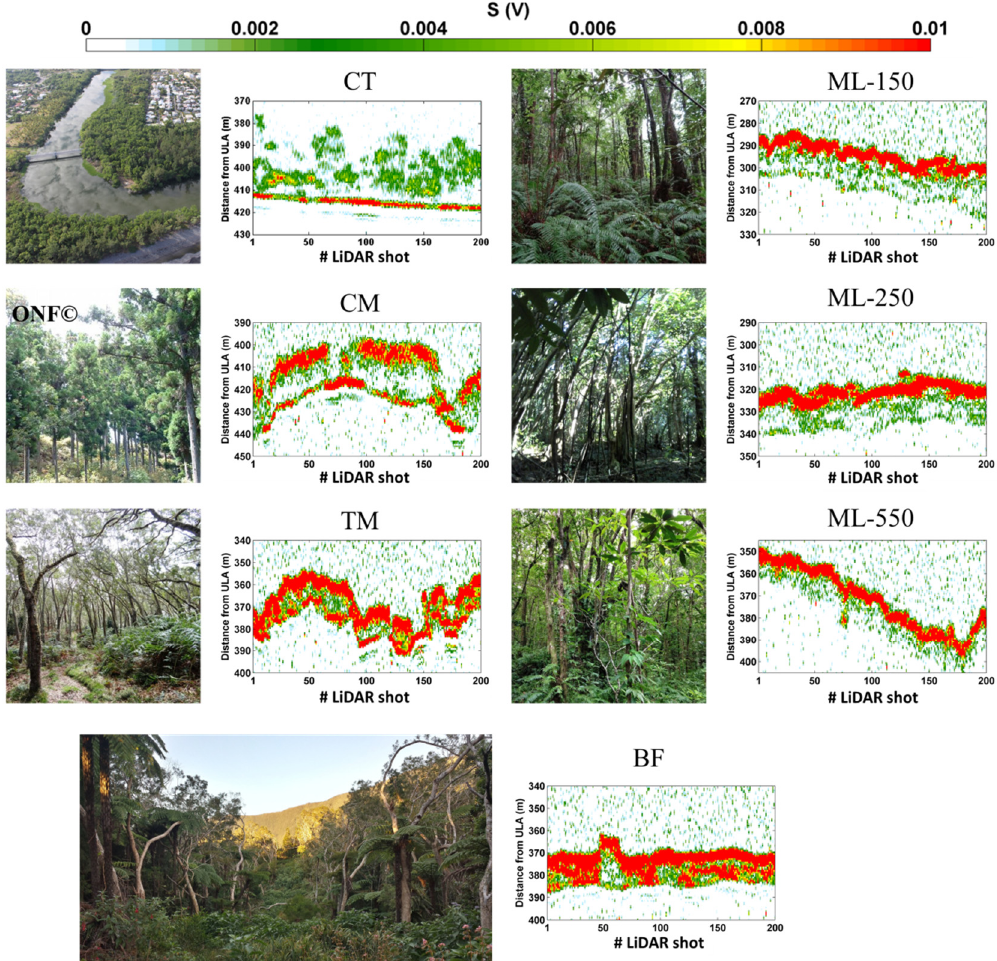
Figure 4. Photos for the 7 studied sites: coastal (CT), Tamarind (TM), Cryptomeria (CM), Bélouve (BF), and Mare-Longue (ML-150, -250 and -550) sites. Examples of continuous LiDAR measurements performed over the sites are also given.